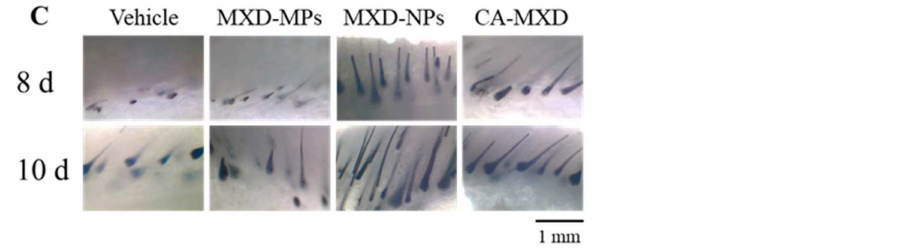
Figure 4. Effect of the repetitive application of MXD formulations on hair growth in C57BL/6 mice. ( A ) Changes in hair area and ( B ) AUC 0–16d in C57BL/6 mice treated with repeated applications of MXD formulations (once a day). ( C ) Image of the skin cross-section of C57BL/6 mice skin after 8 d and 10 d of repeated applications of the MXD formulations (once a day). Vehicle, only the vehicle used to prepare the MXD-MPs and MXD-NPs formulations was applied. MXD-MPs, MXD-MPs-applied mice. MXD-NPs, MXD-NPs-applied mice. CA-MXD, CA-MXD-applied mice. n = 6–10. * p < 0.05 vs. Vehicle for each group. # p < 0.05 vs. MXD-MPs for each group. $ p < 0.05 vs. CA-MXD for each group. The AUC 0–16d of the MXD-NPs-applied and CA-MXD-applied mice were significantly higher than that of the Vehicle and MXD-MPs groups. Moreover, hair growth started at 8 and 10 days after the initial treatment with MXD-NPs and CA-MCD, respectively, and hair-growth effects at 8–10 d after treatment were only observed in mice treated with MXD-NPs.